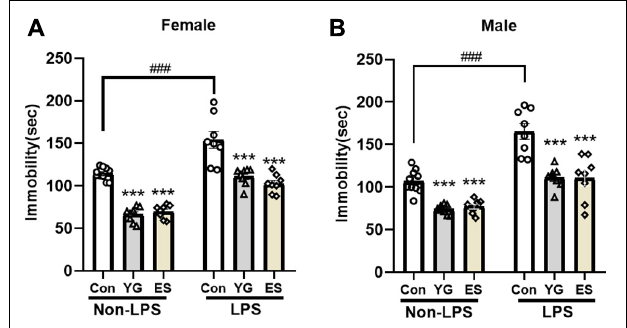
FIGURE 2 | Chronic YG (1 g/kg) and ES (10 mg/kg) displayed significant effects on immobility times in the TST both in (A) female and in (B) male mice as well as in non-LPS treatment or LPS treatment. *** p < 0.001, compared with the control group in non-LPS or LPS treatment, one-way ANOVA, n = 8–10/group. The interaction between non-LPS and LPS treatment was analyzed by two-way ANOVA. ### p < 0.001 compared to non-LPS control